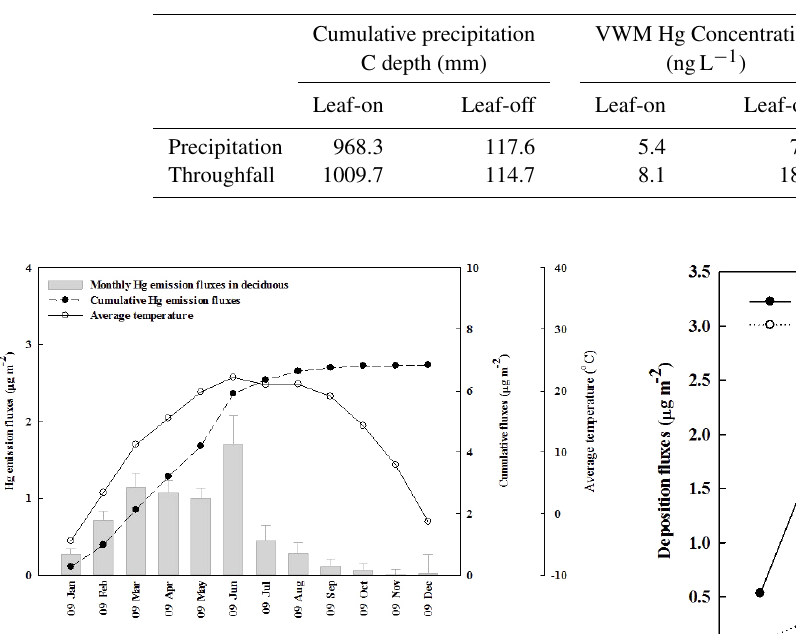
Table 1. Cumulative precipitation depths, VWM Hg concentration, cumulative Hg fluxes in precipitation, and throughfall during leaf-on and leaf-off periods.